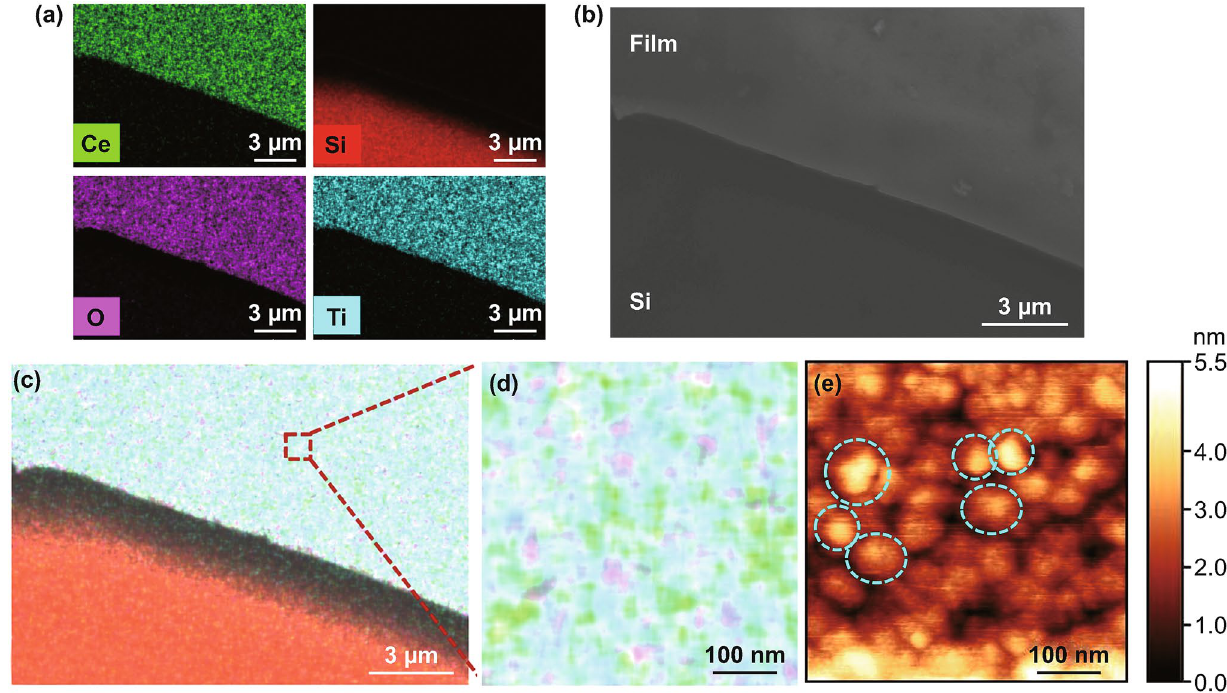
Fig. 7 Top view SEM and AFM images of transferred VAN CeO 2 /STO film on a Si substrate. a EDS images. b SEM image. c , d show blow ups of EDS image for all‑element mapping showing clear nanopillars (light green dots) of CeO 2 embedded in STO matrix of film after transfer. e AFM image of the surface morphology of the film. Some nanopillars are circled with green dashes. The nanopillar structure of CeO 2 is observed in both the EDS image of ( d ) and the AFM image of ( e ) and is perfectly preserved after transfer. (Color figure